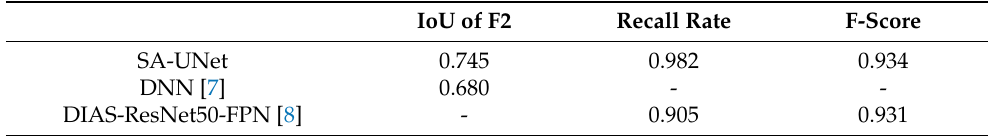
Table 6. Comparison of model results.